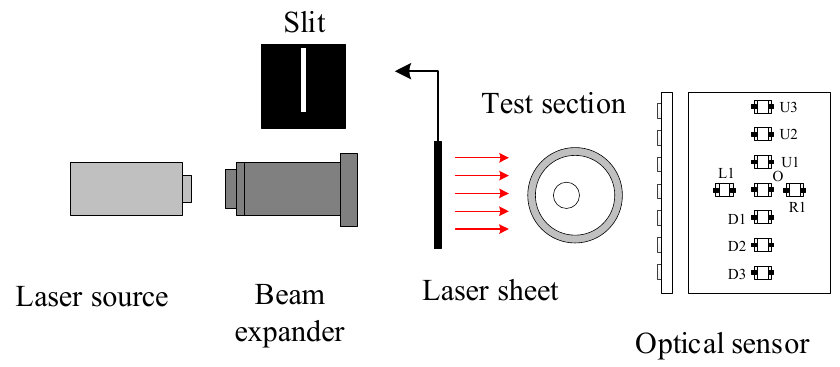
Figure 2. Optical measurement system.